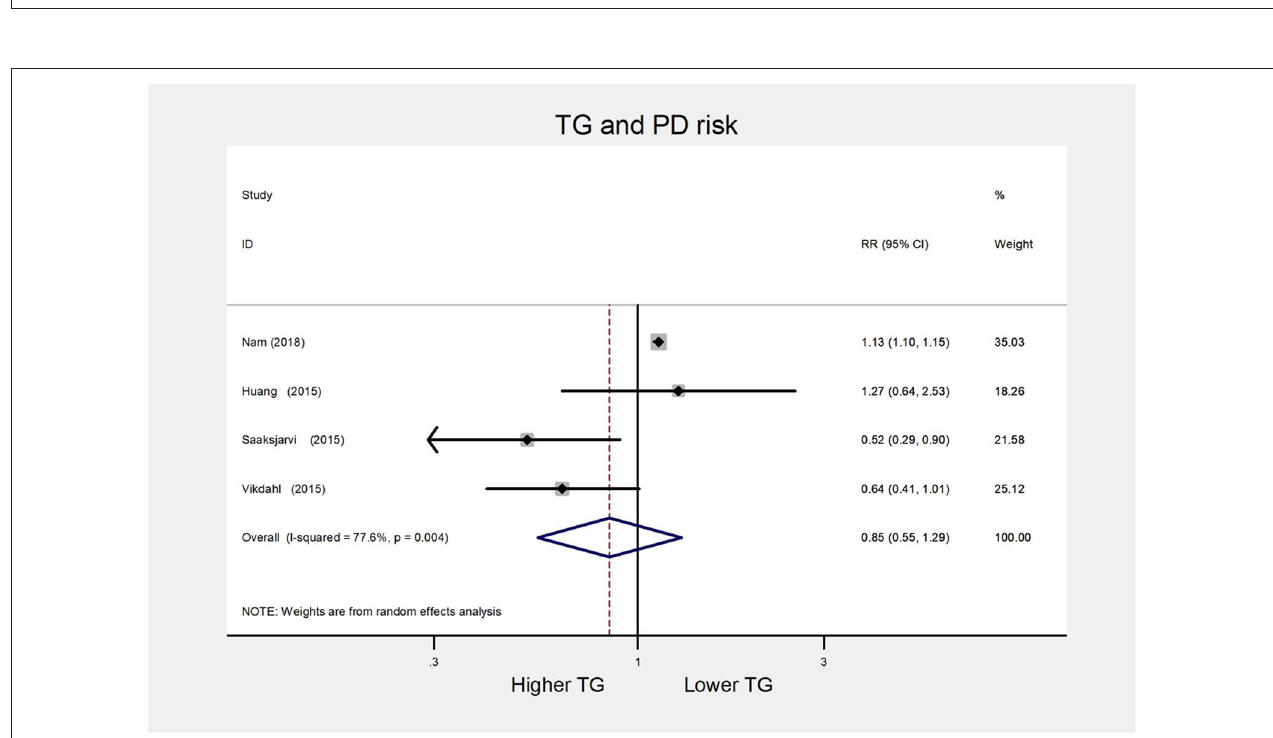
FIGURE 8 | Forest plot presenting the pooled estimate effects(RR) on the relationship between serum TG levels and risk of PD. RR, relative risk; CI, confidence interval; TG, triglycerides; PD, Parkinson’s disease.